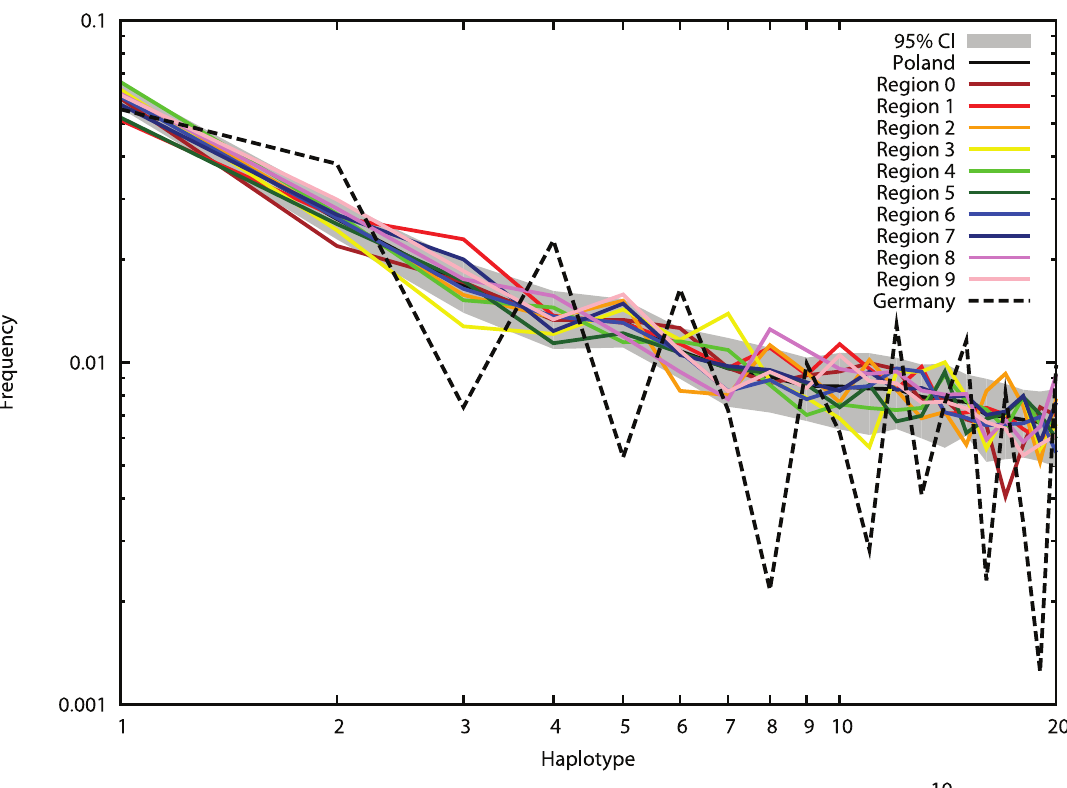
Figure 3. HF of the 20 most frequent haplotypes of the total donor file ( n =123,749) in 100 random samples ( n =5,000) of this file (displayed are mean values and 95% confidence intervals for each haplotype; mean values and corresponding haplotypes are given in Supporting Information S1), in 10 regional sub-files ( n =5,000) and in a German sample ( n =5,000).